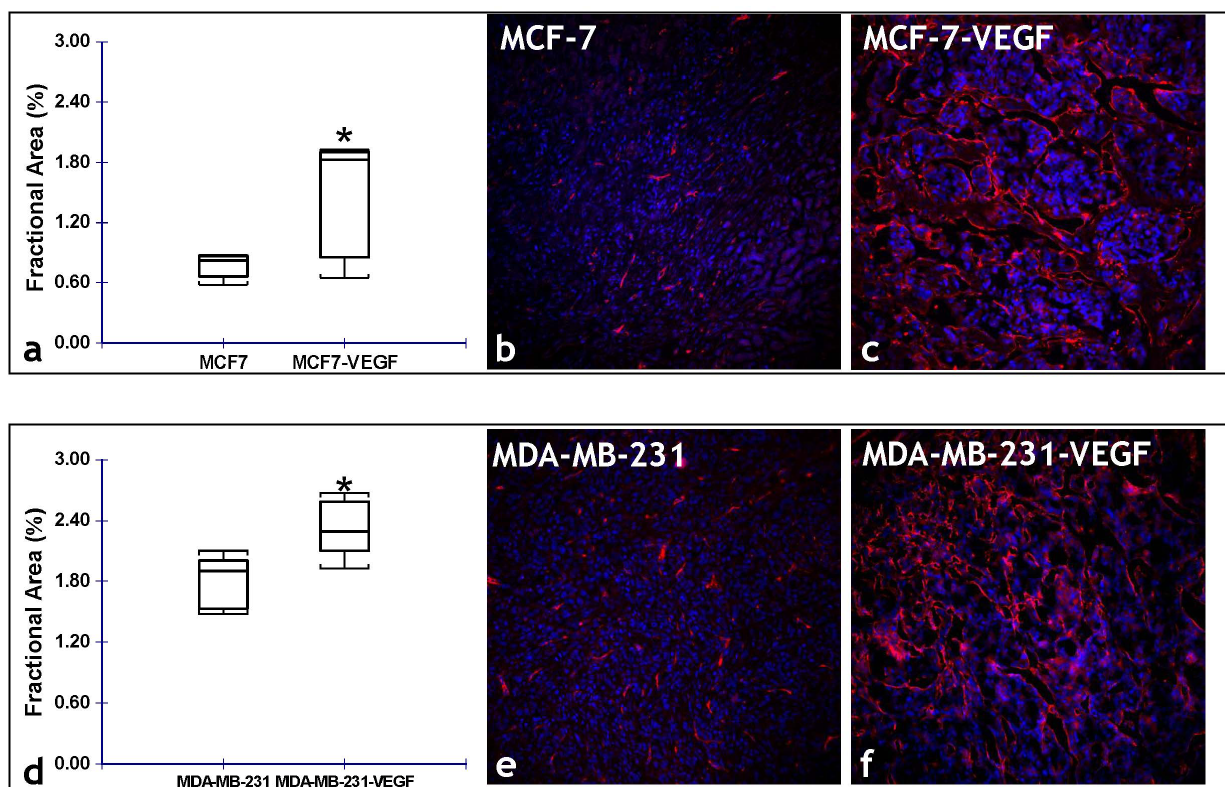
Figure 5. Immunofluorescent validation of VEGF-induced alterations in the angiogenic phenotype. (a) Box-and-whisker plot comparing the stereologically assessed fractional blood vessel area between MCF-7 and MCF-7-VEGF xenografts (*p=0.0476 with the one-tailed Mann-Whitney U Test). Representative fluorescence (CD34-red, DAPI-blue) photomicrographs (20 6 ) from: (b) MCF-7, and (c) MCF-7-VEGF tumor sections illustrating the difference in the fractional area of CD34 stained blood vessels. (d) Box-and-whisker plot comparing the stereologically assessed fractional vessel area between MDA-MB-231 and MDA-MB-231-VEGF xenografts (*p=0.0012 with the one-tailed Mann-Whitney U Test). Representative fluorescence (CD34-red, DAPI-blue) photomicrographs (20 6 ) from: (b) MDA-MB-231, and (c) MDA-MB-231-VEGF tumor sections illustrating the difference in the fractional area of CD34 stained blood vessels.